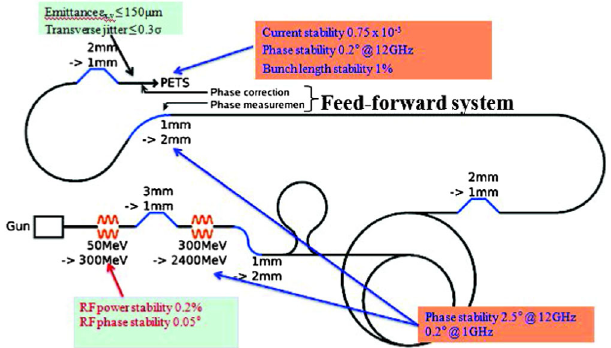
FIG. 19. Phase error as a function of jitter frequency without feed-forward and with 50 and 10 ns gain duration feed-forward. The tolerance of 14 μ m phase error is indicated with a horizon- tal